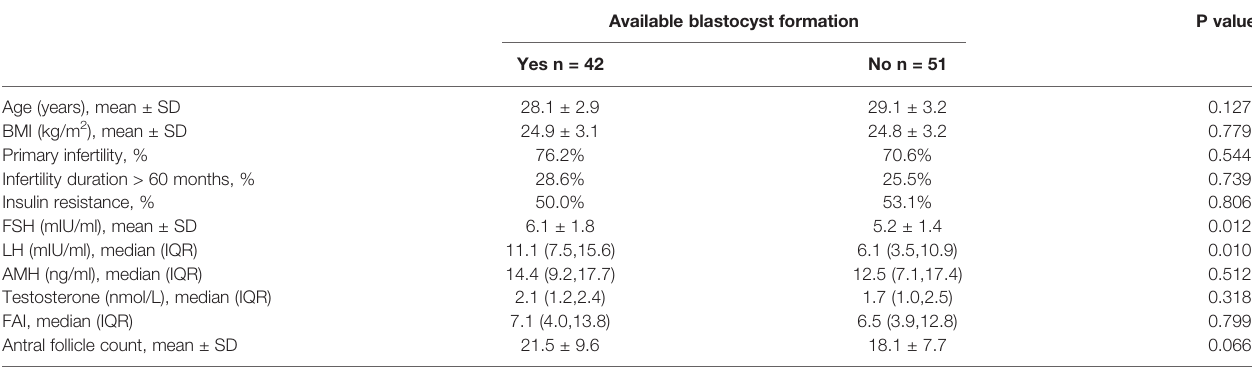
TABLE 5 | Factors in fl uencing available blastocysts formation during IVM-surgery.